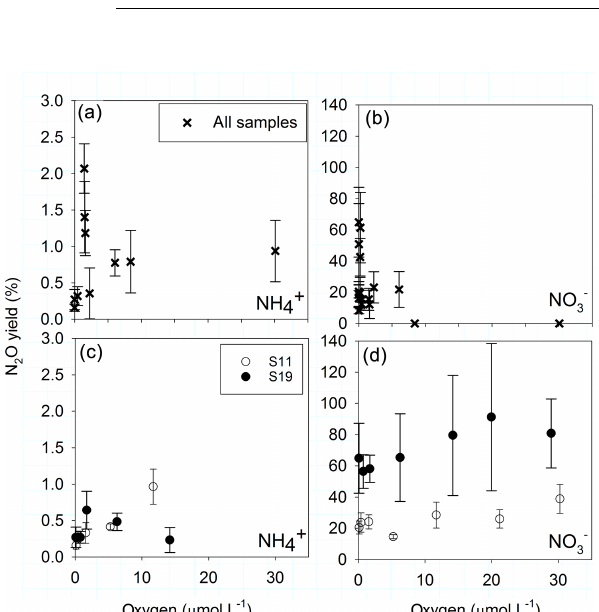
Figure 6. Yields (%) of N 2 O production during NH + oxidation (a, 4 c) and during NO − reduction (b, d) along the natural O 2 gradi- 3 ent (a, b) and for the O 2 manipulations (c, d) from sample S11 (892, 0µmolL − 1 O 2 , 145m) and S19 (894, 0µmolL − 1 , 120m). Error bars present ± SD calculated as error